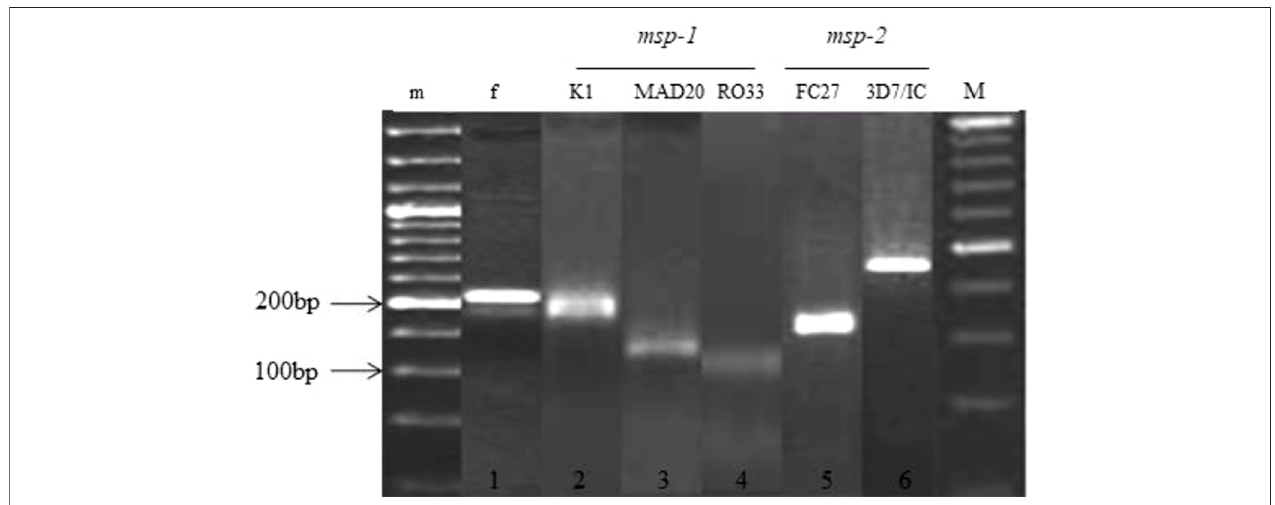
FIGURE1 | Allelic familiesof msp-1 and msp-2 genesof Plasmodium falciparum 1 show thepositiveinfection of Plasmodium falciparum ; 2,3, and 4 represent the corresponding alleles of msp-1 ; 5 and 6 show the alleles of msp-2 ; m is a 50-bp DNA ladder marker, and M is a 100-bp DNA ladder marker.